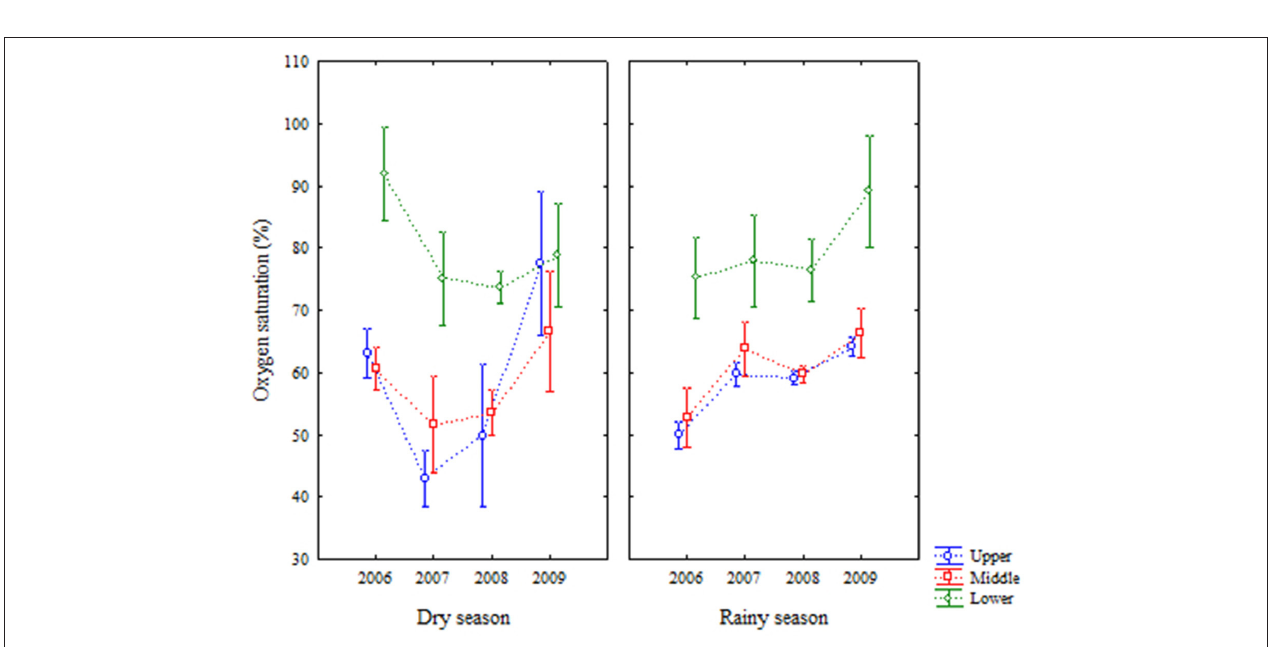
FIGURE 5 | (A) Histogram of observations ( n = 432) for dissolved oxygen, following the normal distribution; (B) Average ( ± standard deviation) of temporal (interannual and seasonal) variations of dissolved oxygen at the Goiana River estuary from 2006 to 2009. Colour scale shows the levels of water quality according to this parameter.